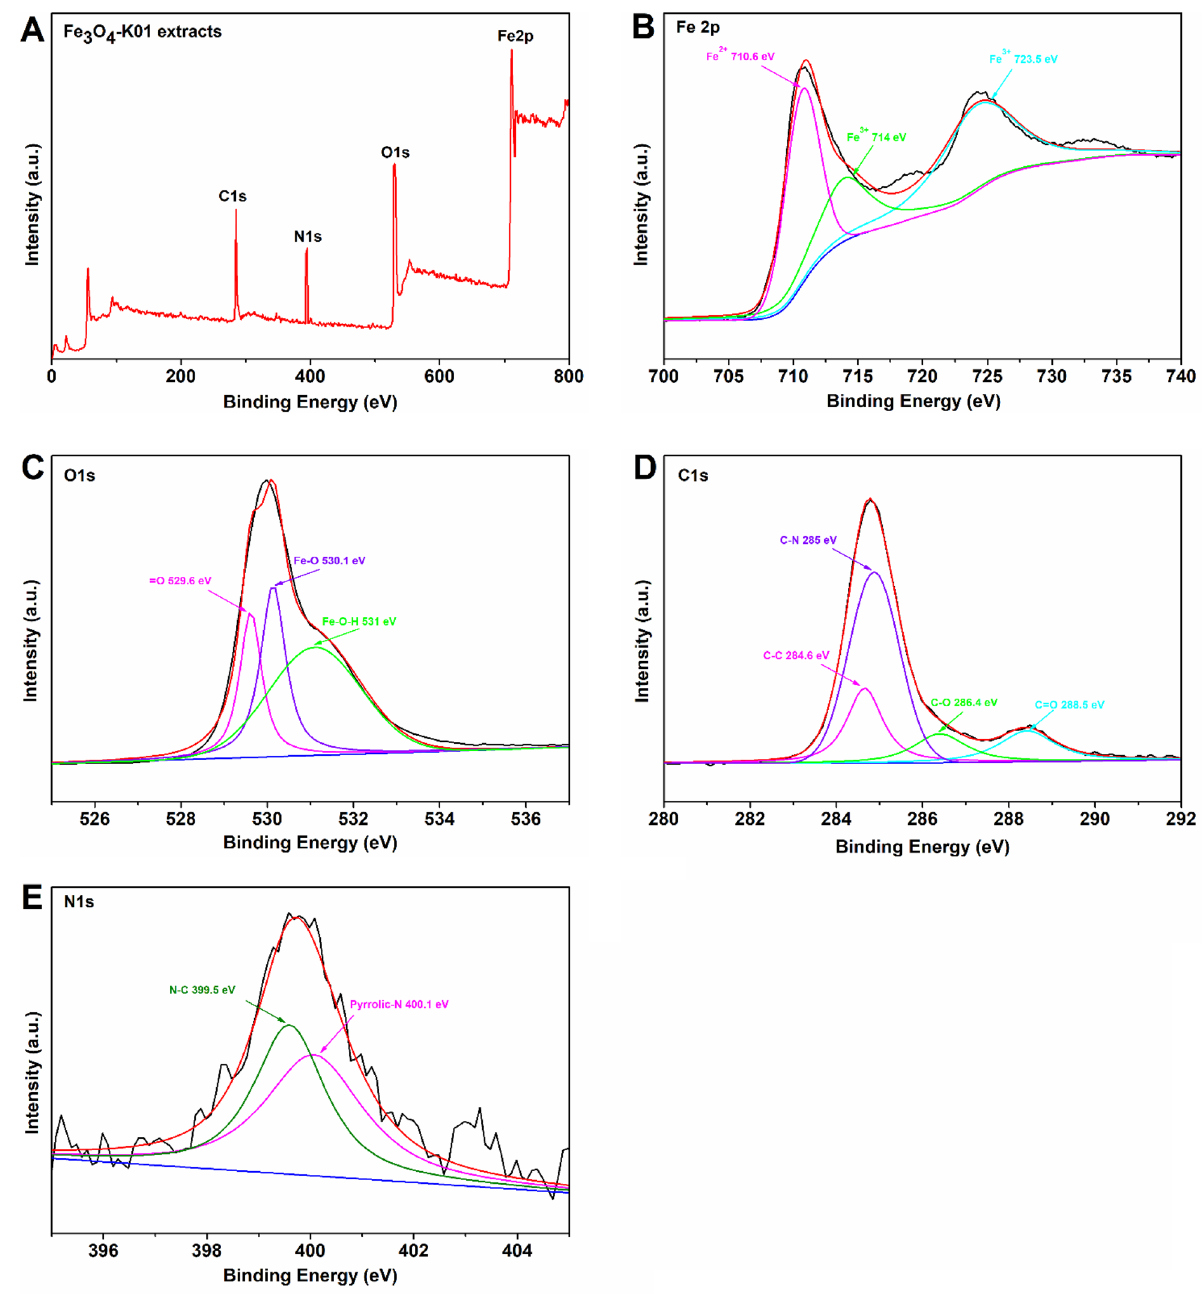
Figure 9. X-ray photoelectron spectra (XPS) of Fe 3 O 4 -K01 extracts. Survey scan XPS spectrum ( A ), Fe 2p ( B ) O1s ( C ), C1s ( D ) and N1s ( E ) spectra of the K01 extracts based synthesis of Fe 3 O 4 nanoparticles. The black lines (little noisy) denote experimental raw data, the overlaid red line is the deconvoluted form of raw data (sum of all fitting data), the baseline is presented by blue color and other color lines are the fitting